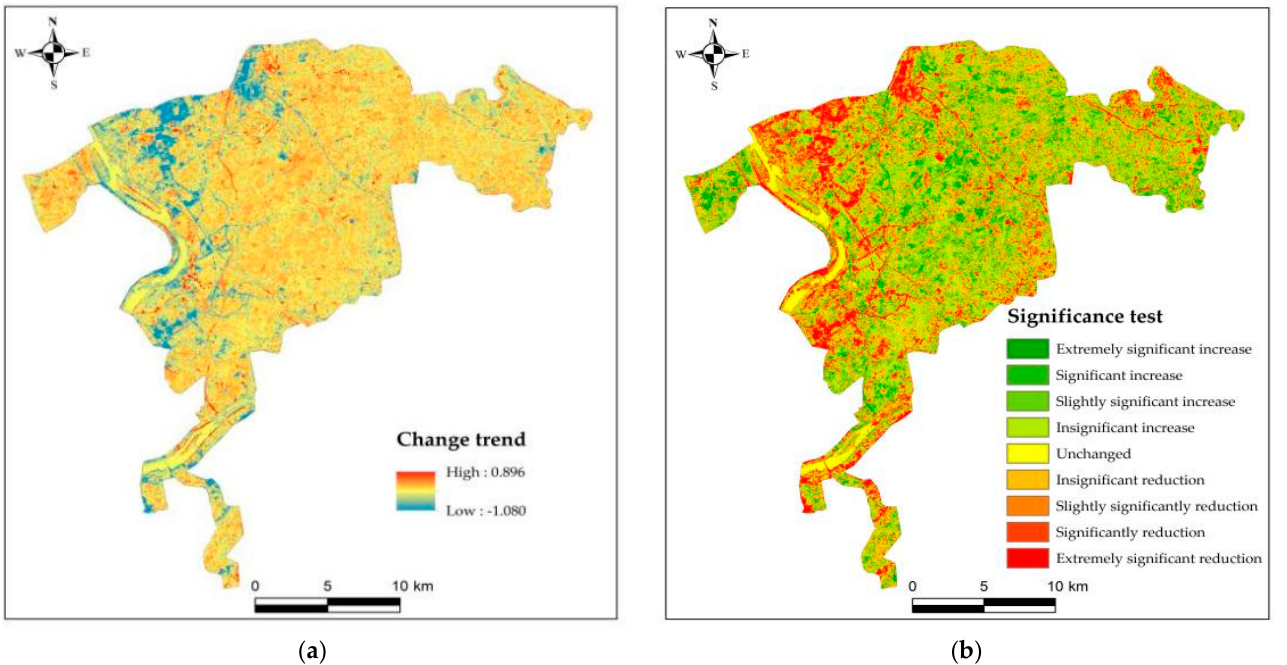
Figure 3. ( a ) NDVI change trend from 2000 to 2020; ( b ) NDVI significance test from 2000 to